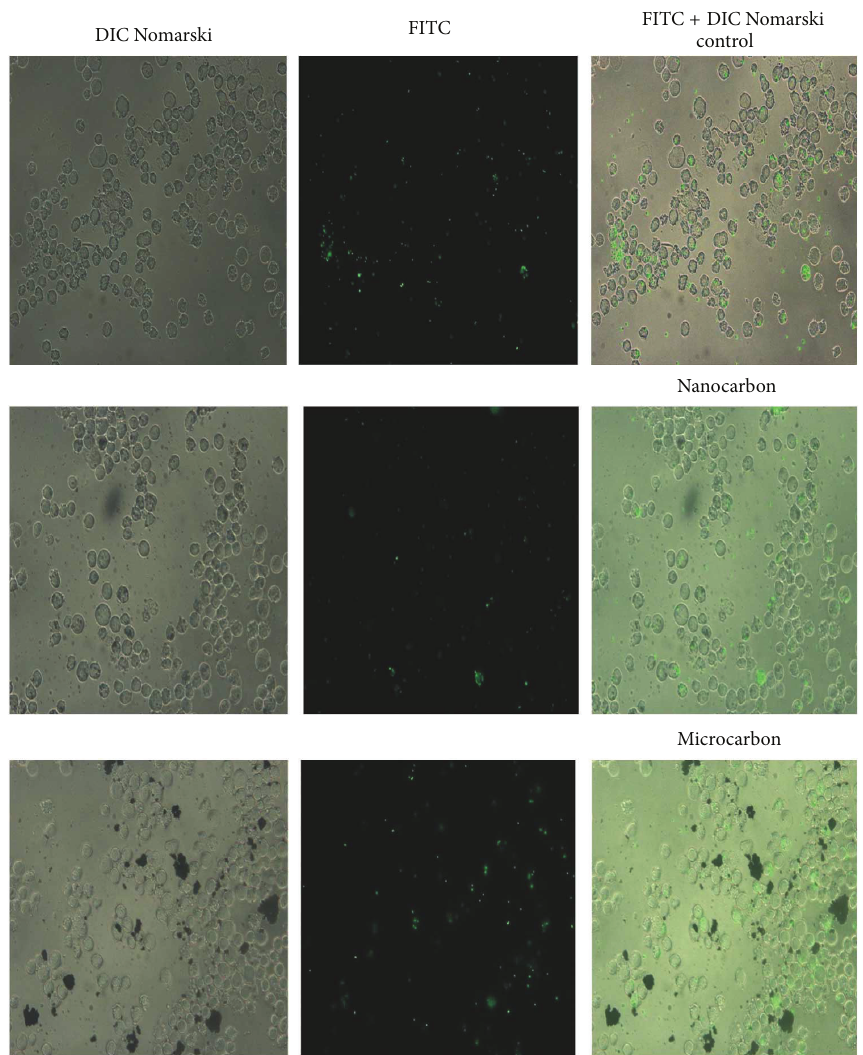
Figure 3: Photomicrographs of THP-1 cells phagocytosing latex beads. THP-1 cells were incubated with TC-50 concentration of carbon particles (nano carbon: 591.4 𝜇 g/mL and micro carbon 687.1 𝜇 g/mL) for 4h; then, latex beads were allowed to phagocytose by THP-1 cells for 1h. After washing, fluorescent images were taken (magnification